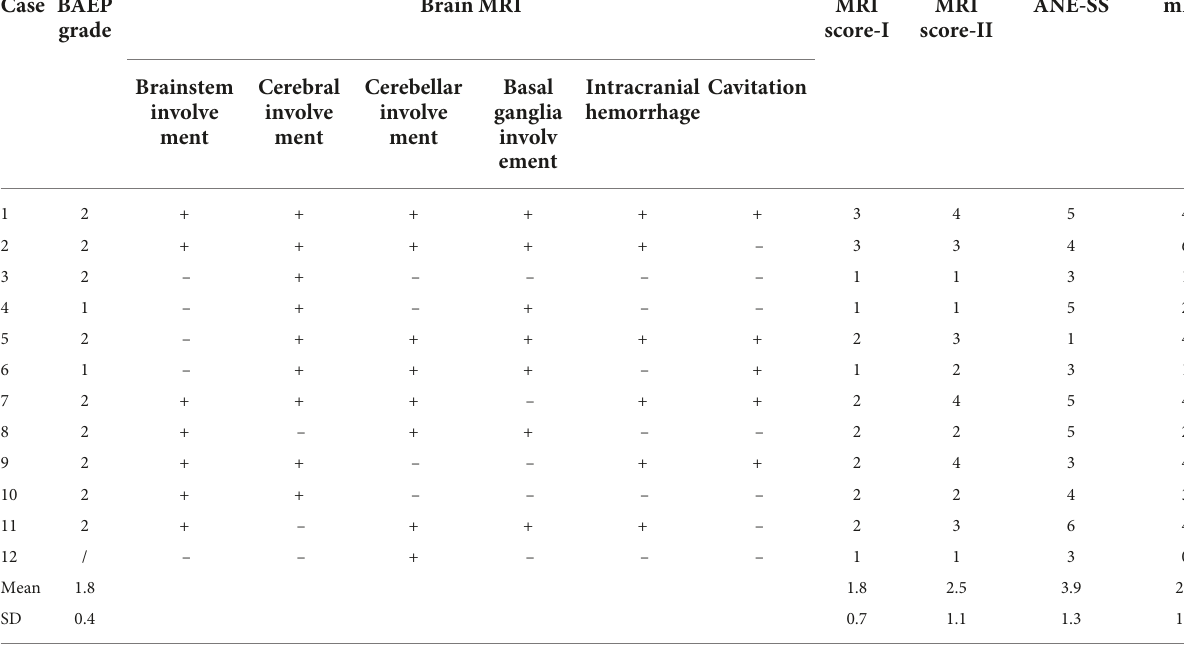
TABLE 3 Neuroelectrophysiology, MR imaging findings, and scoring of the ANE cases. Case BAEP